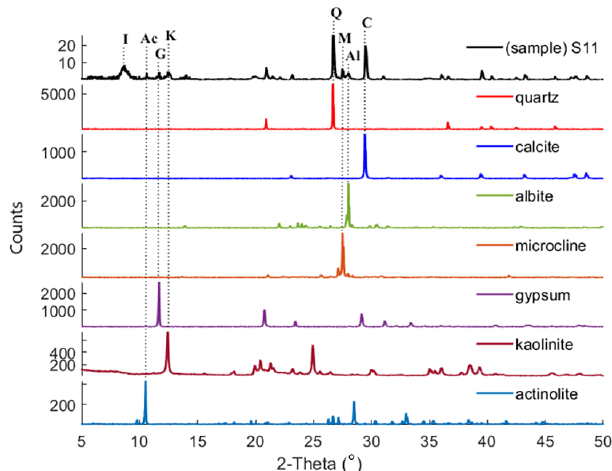
Figure 2. XRD pattern of sample S11 is compared with those of standard reference minerals from AMCSD. Dotted lines connect the diagnostic XRD peak in quartz (Q), calcite (C), albite (Al), micro- cline (M), gypsum (G), kaolinite (K), and actinolite (Ac) to the cor- responding XRD patterns in S11, confirming the presence of these minerals in this particular dust sample. Illite (I) was identified as described in the